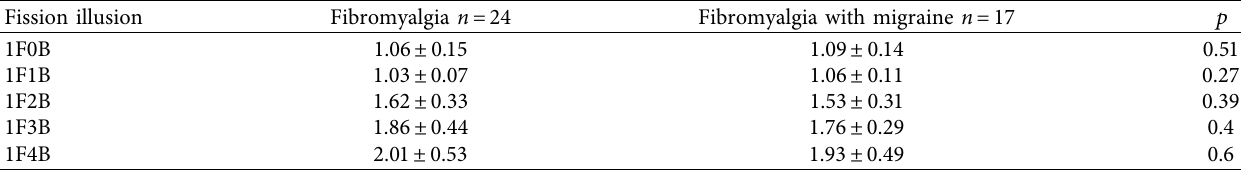
Table 3: Comparison of the fission illusion conditions in patients with fibromyalgia with and without migraine. Data are plotted in the Figure 1(b).